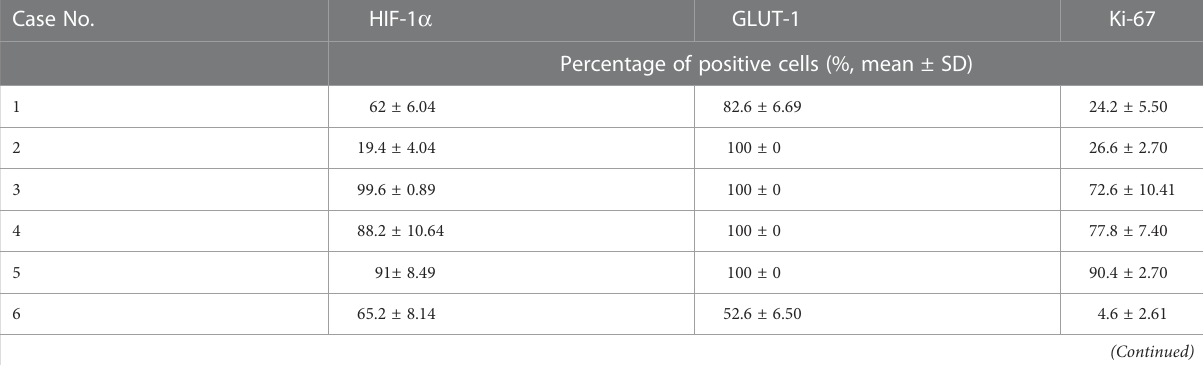
TABLE 2 Immunohistochemical results of tumor cells in body cavity effusions. Case